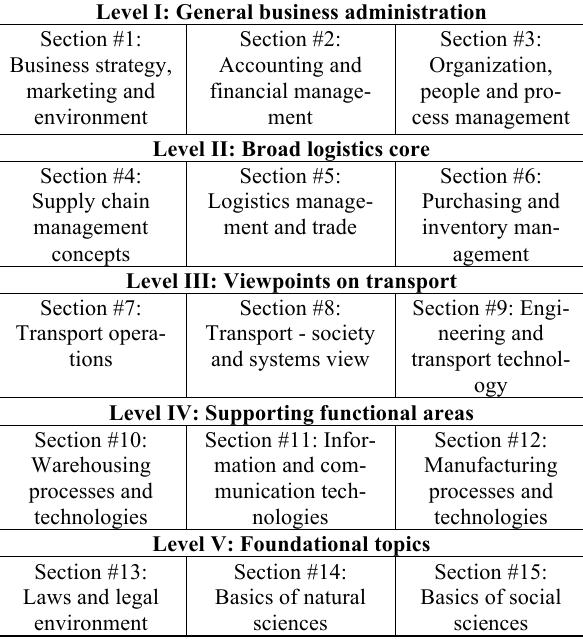
Figure 1. Integrated model of logistics knowledge areas Source: Modified based on Niine and Koppel